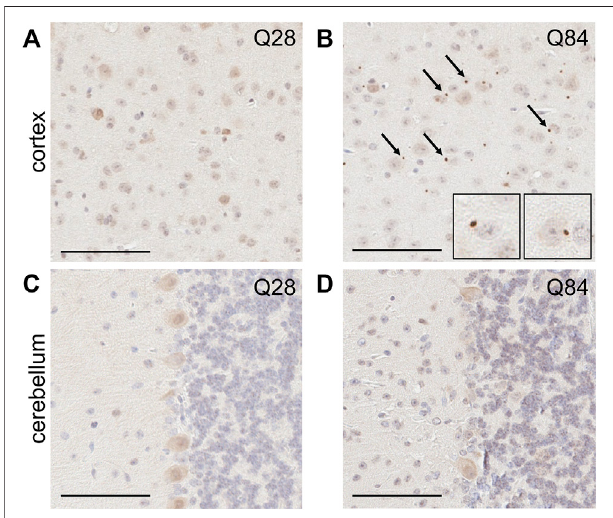
FIGURE 4 | SCA3 mice develop pTDP-43 inclusions in the cortex. Representative images of IHC staining for pTDP-43 in the cortex (A – B) and cerebellum (C – D) of Q28 (A , C) and Q84 (B , D) mice at 6 months of age. Similar results seen at 3 months; see Supplementary Figure S8 . Arrows mark inclusions. Insets in (B) are higher magni fi cation images of inclusions. Scale bars are 100 µm.